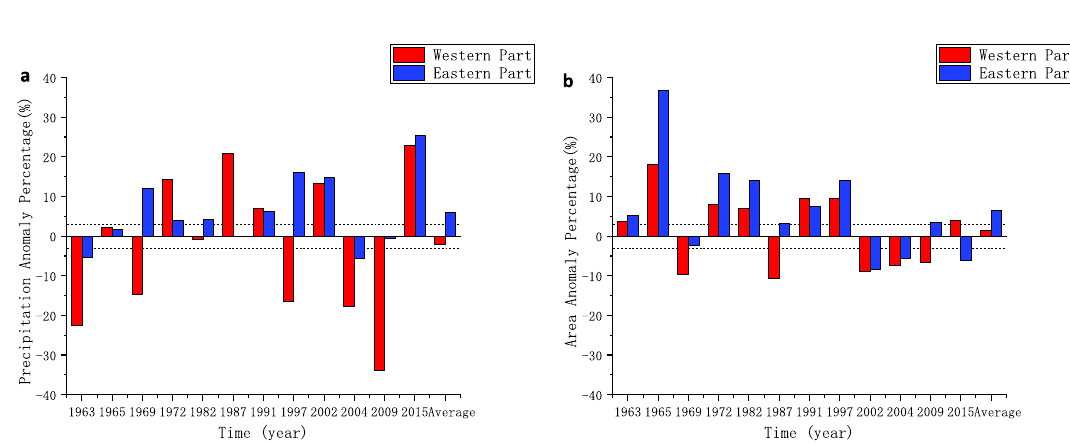
Figure 6. ( a ) Annual precipitation anomaly percentage and ( b ) area anomaly percentage in El Niño region in El Niño years were calculated respectively and the result is shown in Fig. 6. The areas of the western arid region and the eastern arid region in most El Niño years were greater than the average of their respective areas within 56 years. In 7 of the 12 El Niño years, the area of the western part is larger than the average, and in 8 of the 12 El Niño years the area in the eastern part is larger. The percentage of the area anomaly in the eastern part is larger than that in the western part in 10 years, indicating that the area in the eastern part has increased more. In 5 years of 12 El Niño years, the precipitation in the western arid region is obviously larger than the average, obviously smaller than the average in 5 years, and not significantly different from the average in 2 years. By using the linear regression method, the percentage of precipitation anomalies in the western arid region and the Niño 3.4 index were analyzed (R 2 = 0.10), indicating that the linear relationship between the percentage of precipitation anomalies in the western arid region is not obvious. The precipitation in the eastern arid region was significantly larger than the average in 7 of the 12 El Niño years, significantly smaller than the average in 2 years, and not significantly different from the average in 3 years. The two years with less than average precipitation in the eastern arid region were 1963 and 2004, both of which were years with small Niño 3.4 index. By using the linear regression method, the percentage of precipitation anomalies in the eastern part and the Niño 3.4 index were analyzed (R 2 is 0.70), and between the percentage of area anomalies and the Niño 3.4 index, R2 is 0.44. The same analysis was performed on the western arid region, and the correlations were not significant. The above results show that the El Niño events increase the area and the average precipitation of China’s arid region. In the western arid region, the correlation between precipitation and El Niño is not obvious. In the eastern arid region, both average precipitation and the area increased. Figure. 7a shows the distribution of the 200 mm isohyet in composited El Niño years and Fig. 7b shows the composite anomaly distribution of precipitation in Northwest China. The picture shows that the western part of Inner Mongolia, which is also the eastern arid region, experienced a significant decrease in precipitation in El Niño years. In the western arid region, most part of Xinjiang showed an increase in precipitation without passing the significant test. Eastern part of Xinjiang showed a decrease trend and parts of them passed the significant test. The result is consistent with the above analysis of El Niño’s less significant effect in the western arid region compared to the eastern part.